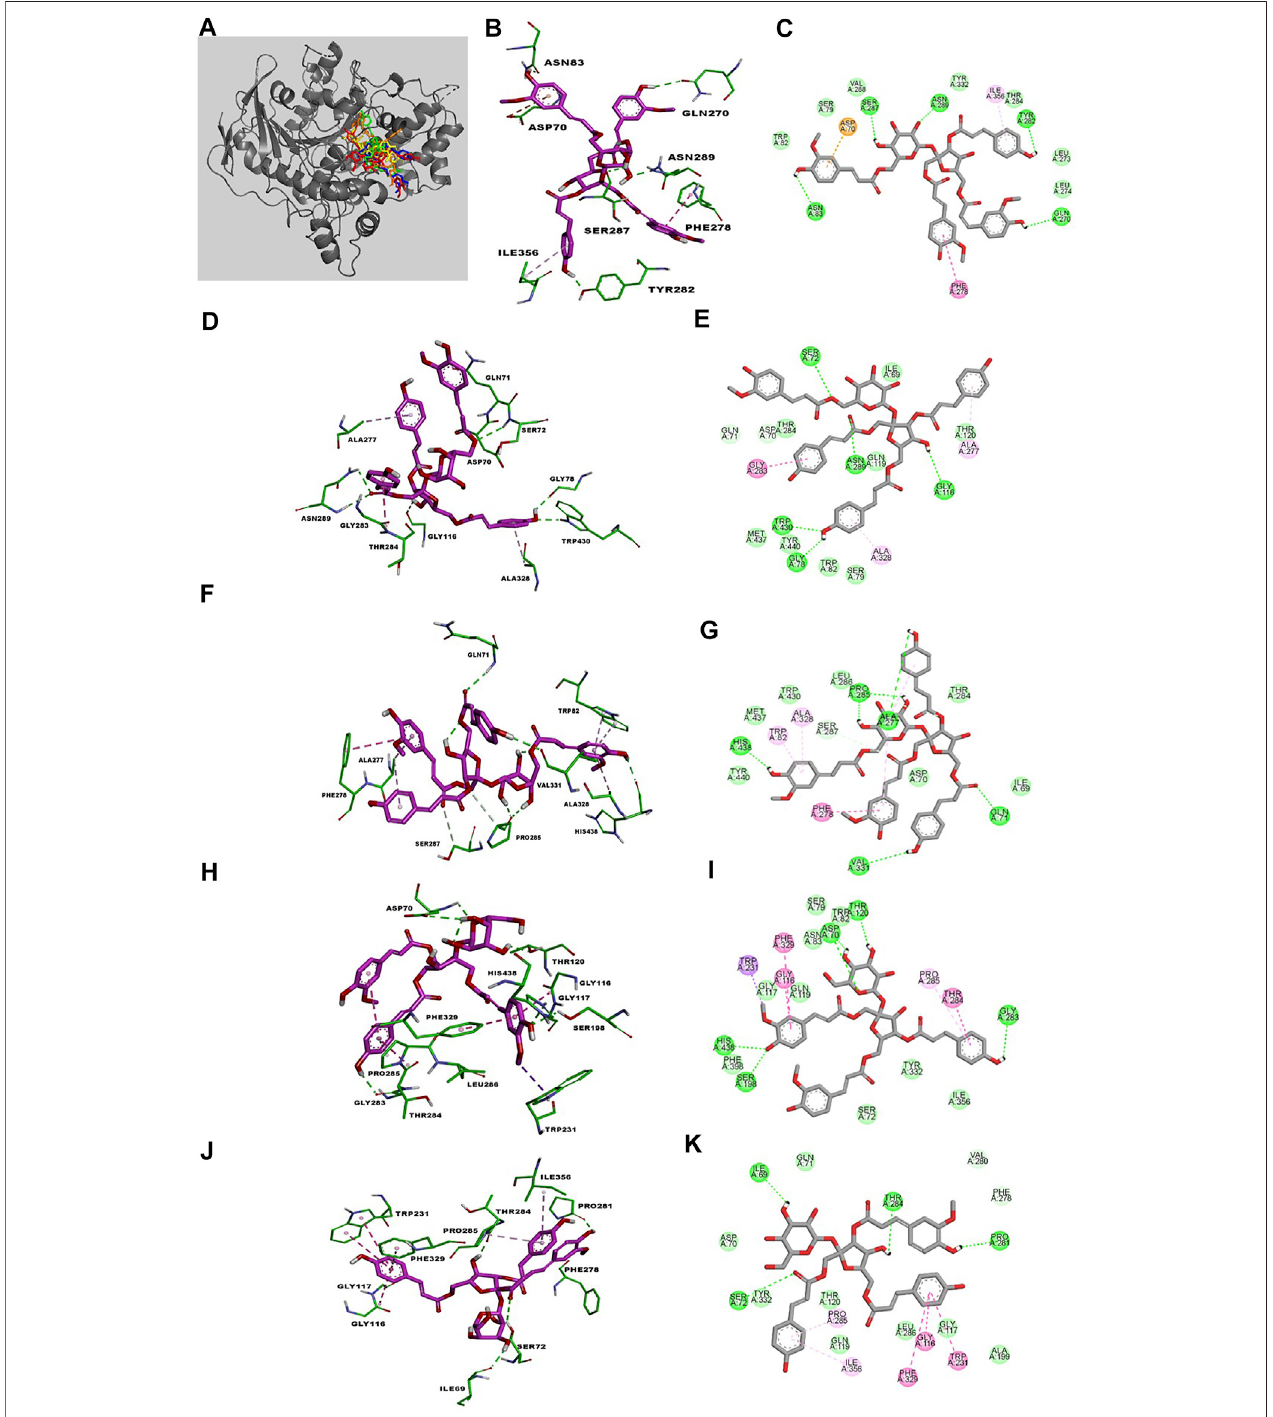
FIGURE3| Thebestposesofcompounds 30 – 34 ( 30 ,red; 31 ,green; 32 ,orange; 33 ,yellow; 34 ,blue)dockedwithBuChE (A) .Moleculardockingmodels (B,D,F, H, J) and 2D ligand interaction diagrams (C, E, G, I, K) of BuChE inhibition at the catalytic pocket by compounds 30 – 34 , respectively. Different interactions between compoundsand aminoacidresiduesinthecatalytic sitearedesignatedbythefollowing:thicklightpurplestickmodelsrepresent compounds 30 – 34 ,greendottedlines represent hydrogen bonds, light green lines represent Van der Waals interactions, dark pink lines represent π – π and π – σ interactions, and light pink lines represent π – alkyl